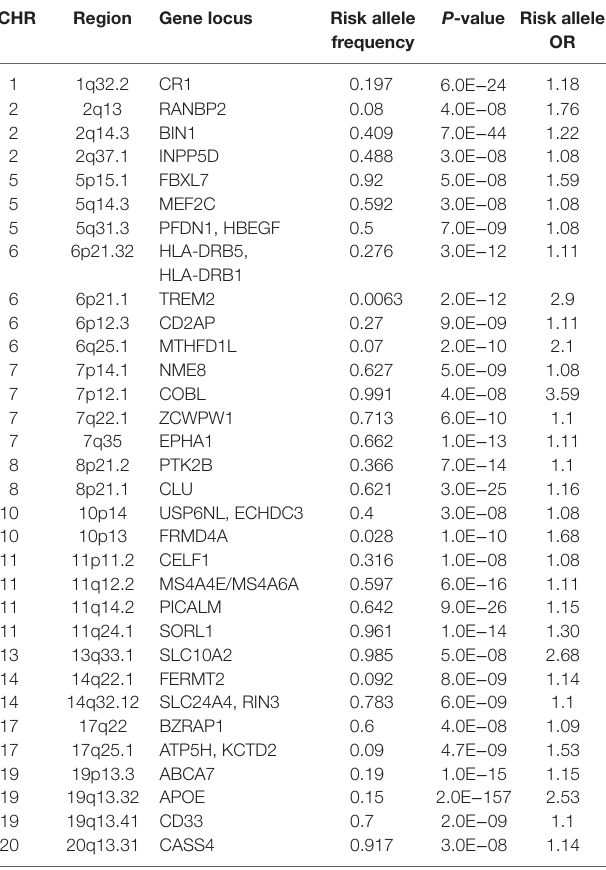
TABLe 1 | AD associated loci from the NHGRI-EBI GWAS Catalog. CHR Region Gene locus Risk allele